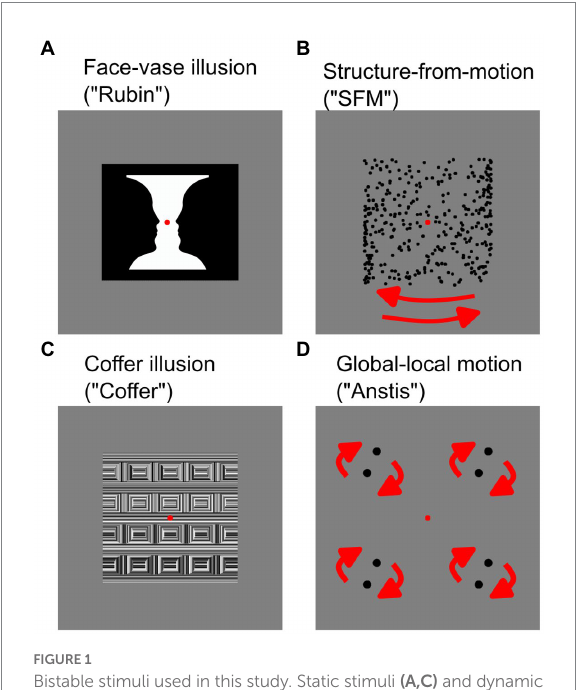
FIGURE 1 Bistable stimuli used in this study. Static stimuli (A,C) and dynamic stimuli (B,D) . For dynamic stimuli (B,D) movement direction of items is indicated by red